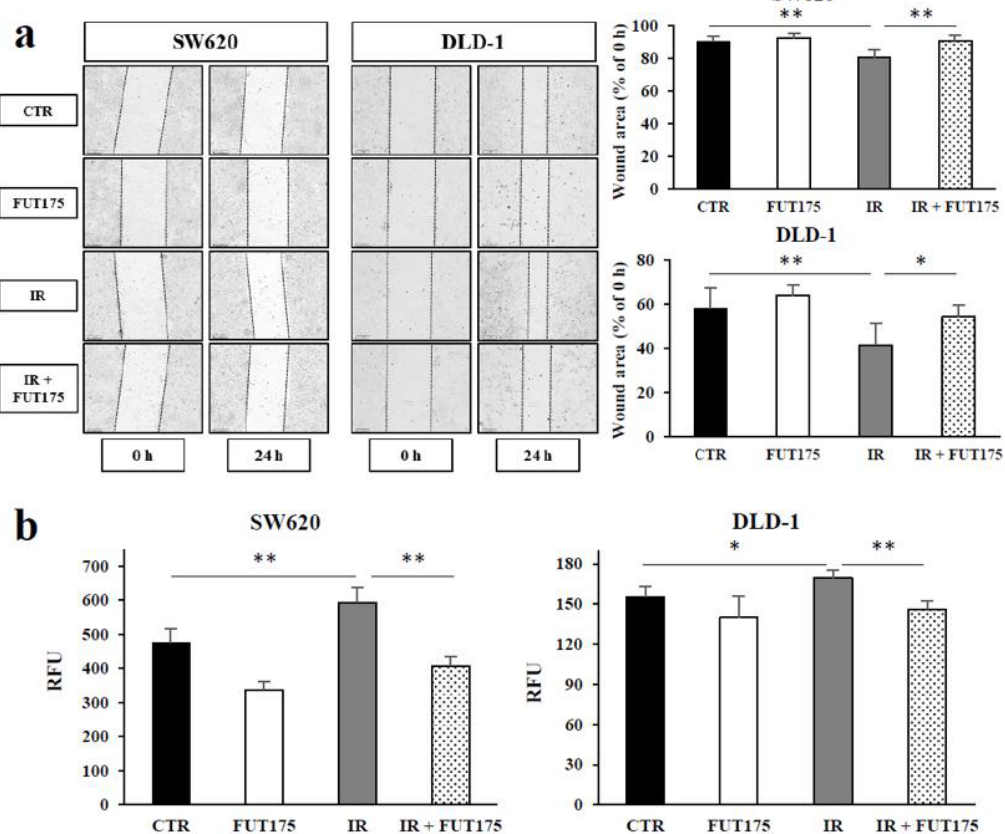
Figure 5. Nafamostat mesilate (FUT175) suppresses ionizing radiation (IR)-induced cell migration and invasion in vitro. ( a ) The cells were treated with FUT175 (80 µ g/mL) for 3 h prior to irradiation (5 Gy). Wound healing was measured at 0 and 24 h after the treatment. The wound area of the combination groups was significantly wider than that of the IR groups (SW620: 90.6% ± 3.8 vs. 80.4% ± 5.0, p < 0.01; DLD-1: 54.2% ± 5.6 vs. 41.4% ± 9.9, p < 0.05). ( b ) Immediately after irradiation (5 Gy), the cells were harvested and reseeded into a 96-well plate at a density of 2 × 10 5 cells/well and incubated with FUT175 (80 µ g/mL) for 24 h. Invading cells were quantified by reading the fluorescence at 480 nm/520 nm. The invasion index of the combination groups was significantly lower than that of the IR groups (SW620: 407.5 ± 25.8 vs. 594.0 ± 43.9, p < 0.01; DLD-1: 146.3 ± 6.4 vs. 169.5 ± 5.8, p <